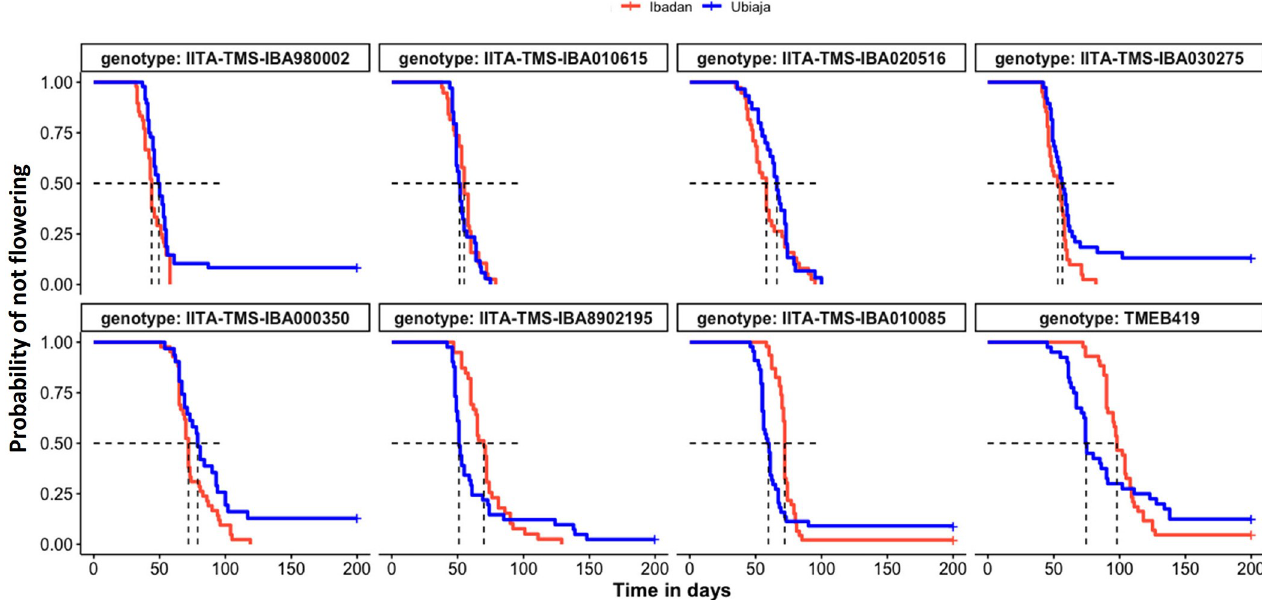
Fig 3. Flowering time probabilities for eight genotypes in Ubiaja and Ibadan. Kaplan-Meier curves show the time course of probability of not flowering in each location. Horizontal and vertical dashed lines indicate, respectively, 50% probability of flowering and corresponding days after planting (DAP).